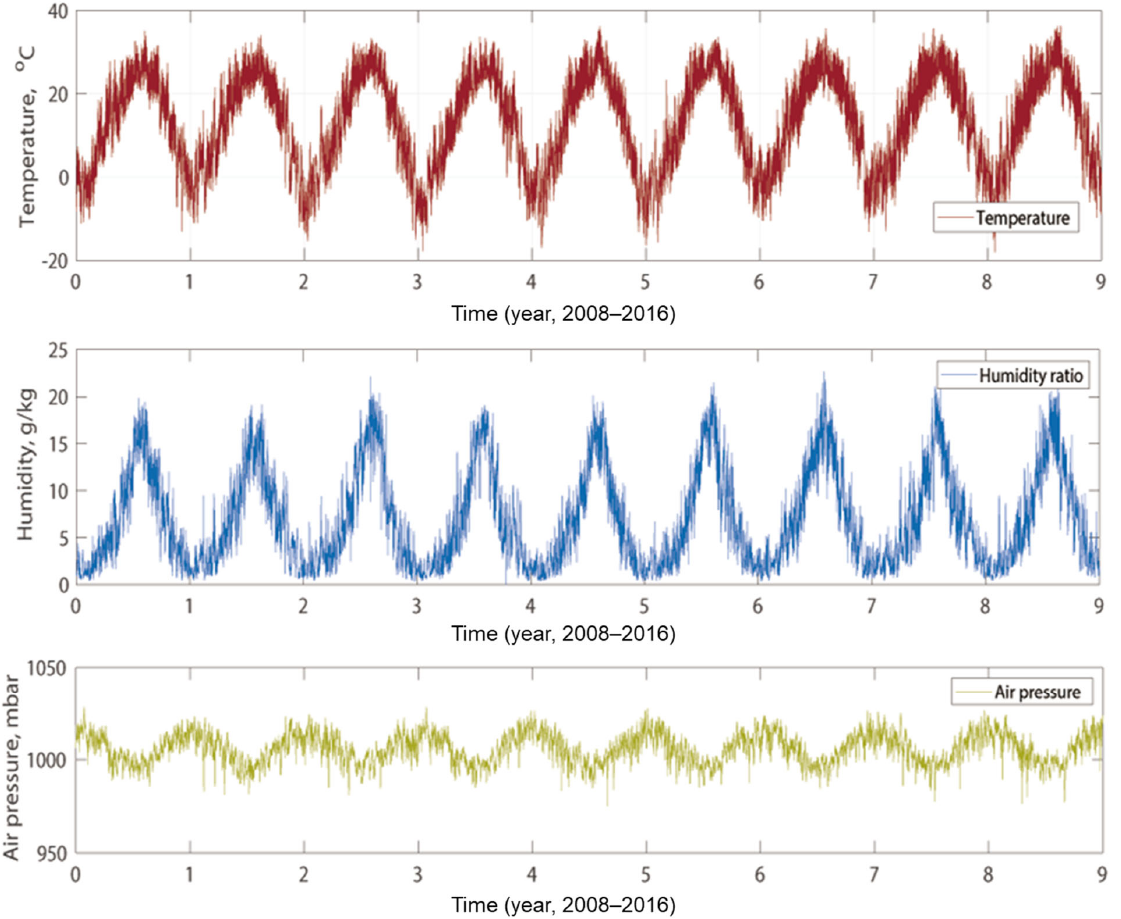
Figure 3. Historical data for 9 years (2008–2016): temperature, humidity ratio, and air pressure.